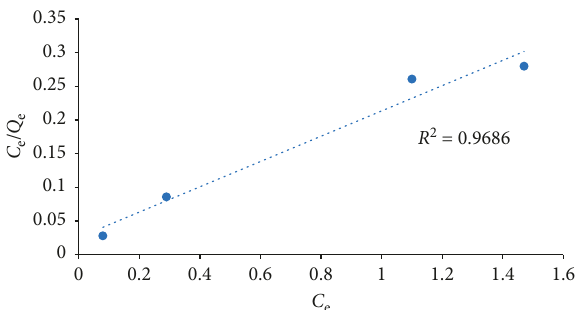
Figure 11: Isothermal adsorption of the saponin compound by Resion Diaon WA30 with 10% (w/v).